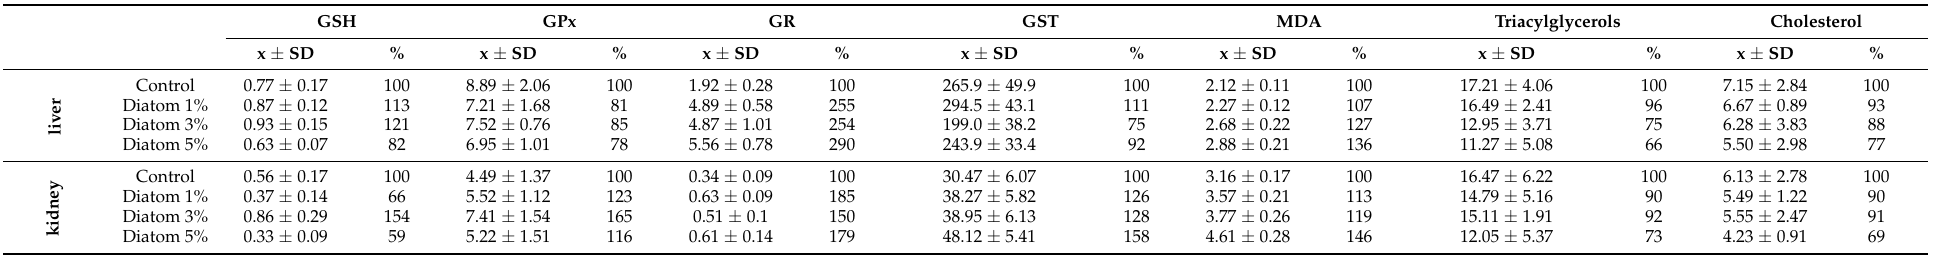
Table 1. Effect of diet supplementation with lyophilized diatom solutions of different concentrations on reduced glutathione (GSH-mmol/g tissue), glutathione peroxidase activity (GPx-U/mg protein/min), glutathione reductase (GR-U/mg protein/min), glutathione transferase (GST-U/mg protein/min), malondialdehyde activity (MDA µ mol/mg protein), triacylglycerols ( µ mol/g tissue), and cholesterol ( µ mol/g tissue) in mouse liver ( n = 10) and kidney ( n = 10), expressed as means ± SD and as a percent of control values. GSH GPx